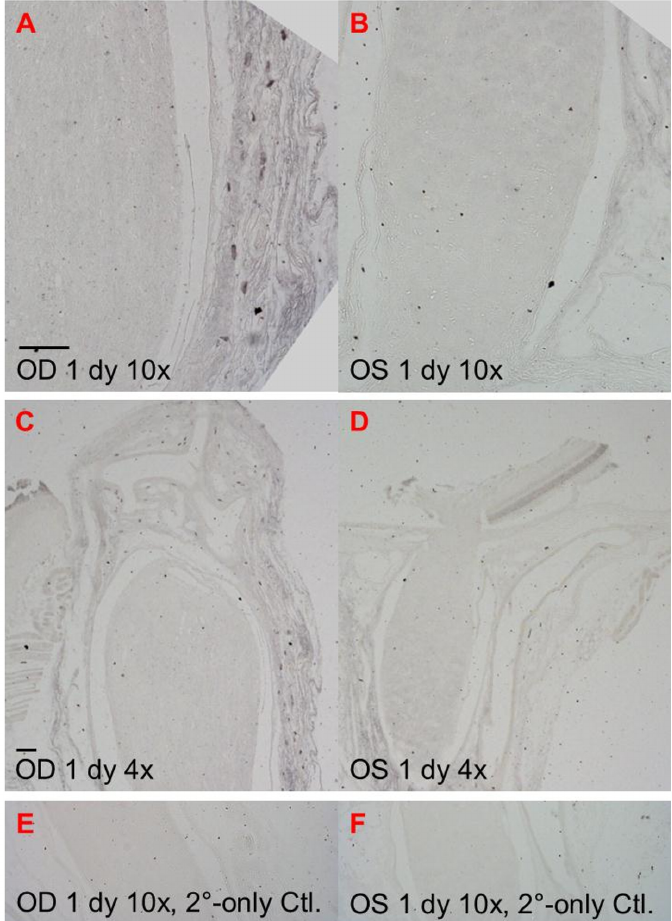
Fig 3. SUR1 staining in rat ON after rAION. Panels A & C show 1 day post-rAION (OD) longitudinally sectioned ON at different magnifications. Panels B & D show different magnification of the uninfarcted ON (OS) from the companion eye to the injured ON. Panels E & F show secondary-only controls from the same animals demonstrating the lack of non-specific background staining for both injured and non-injured ON. Scale bars are 100 μ m. OS & OD are standard notation for left eye and right eye,